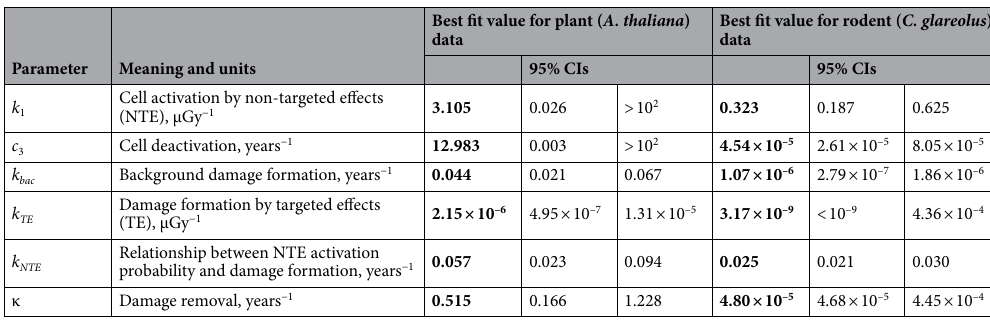
Table 3. Best-fit model parameter values for the plant and rodent data sets. Best-fit parameter values are indicatd in